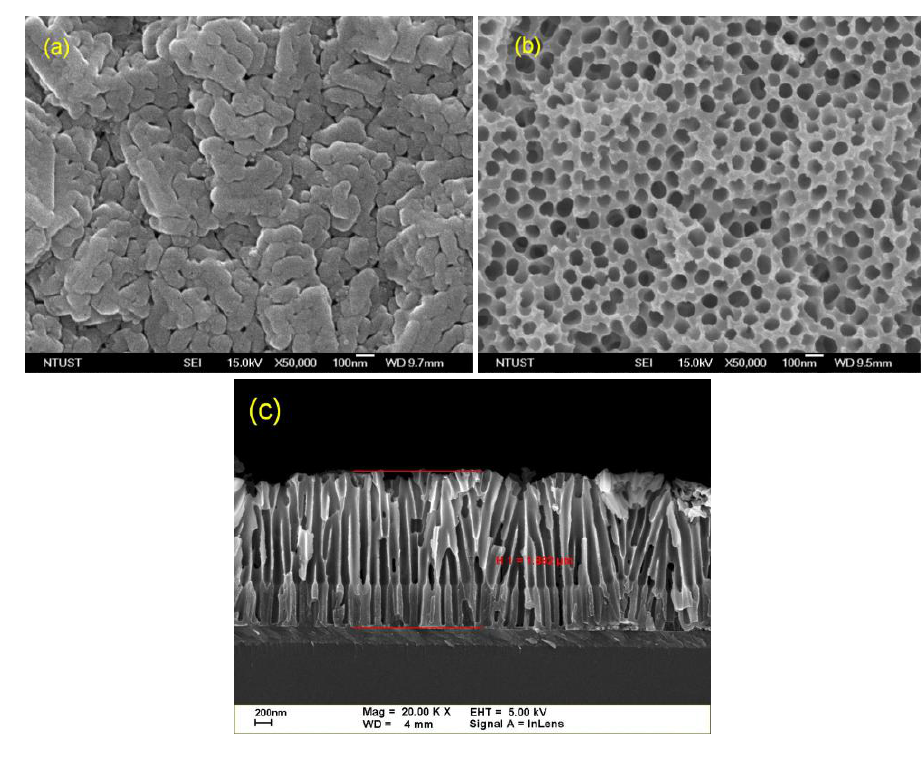
Figure 2. SEM images of the AAO layer: (a) processed under 60 V, 10 min, (b) processed under 60 V, 40 min (the pore-widening step), (c) illustrated with cross-section before the pore-widening